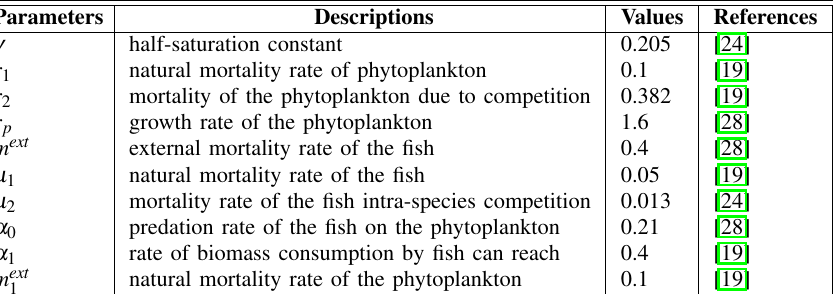
P ARAMETERS VALUES USED FOR THE NUMERICAL SIMULATION .